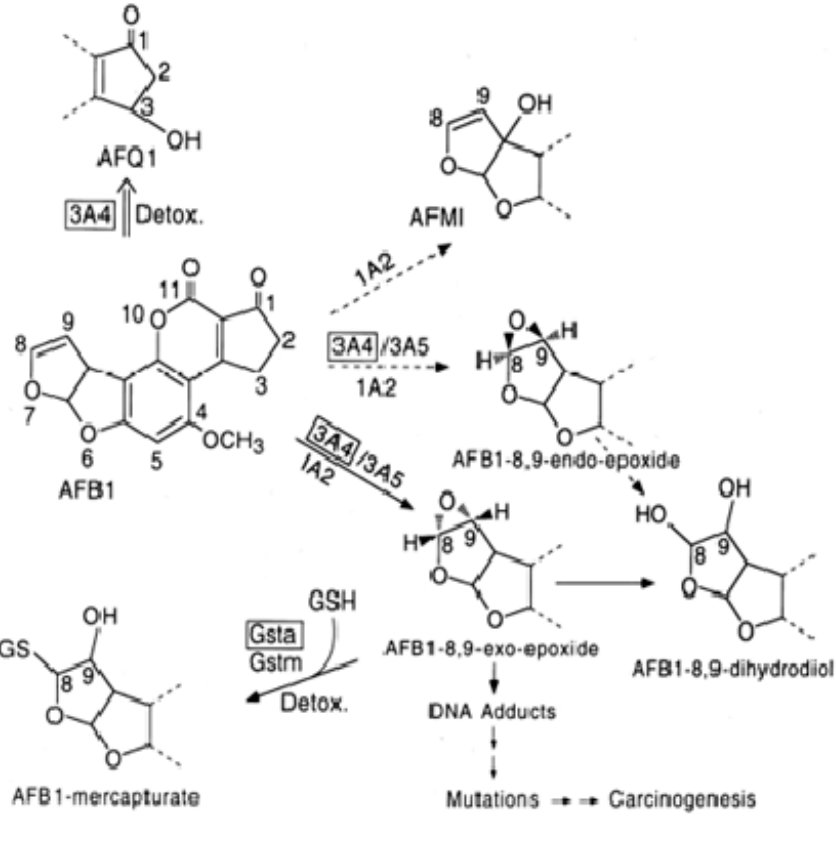
Figure 8. Proposed mechanism of aflatoxin B1-induced DNA damage (Adapted from Nwankwo et al.